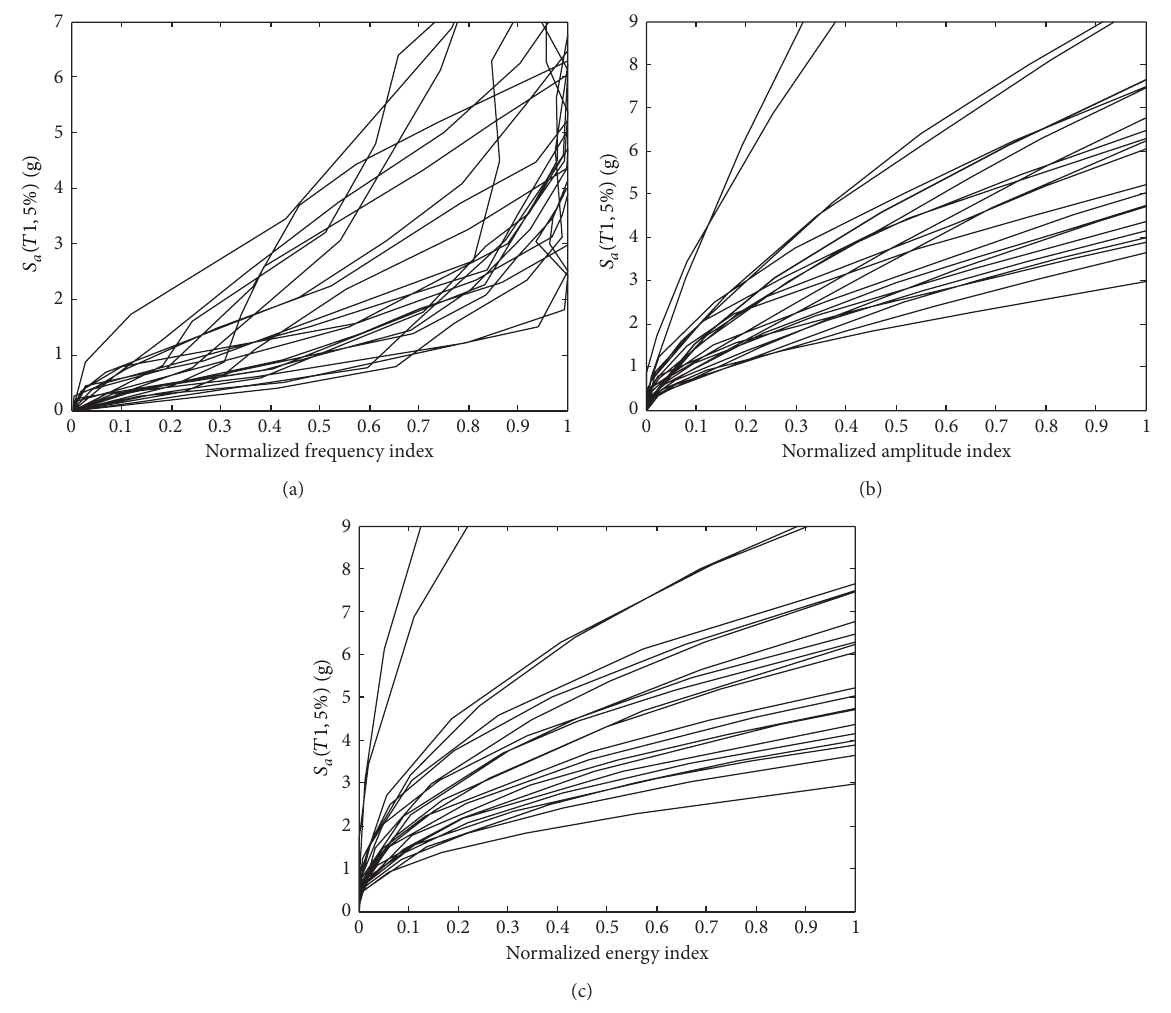
Figure 11: IDA curves for feature indexes. (a) Frequency, (b) amplitude, and (c) energy. Table 4: Feature indexes for intensity levels.